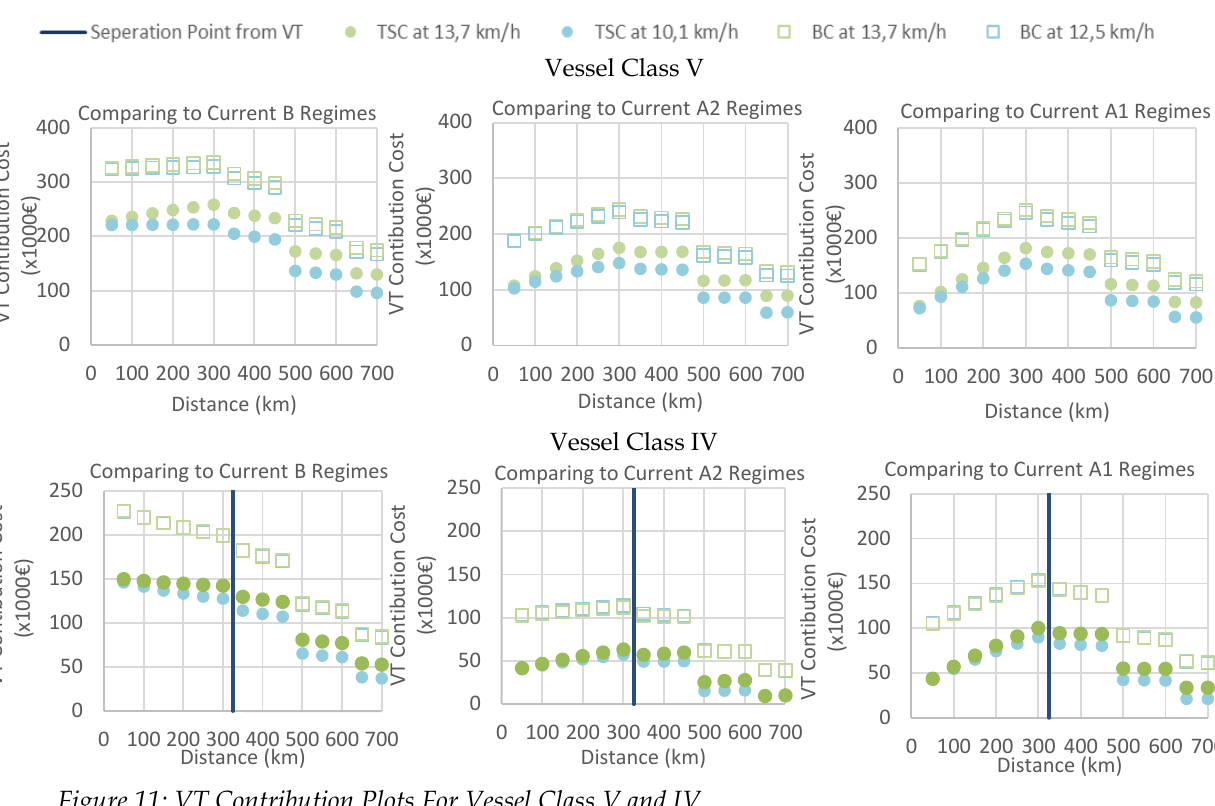
Figure 11: VT Contribution Plots For Vessel Class V and